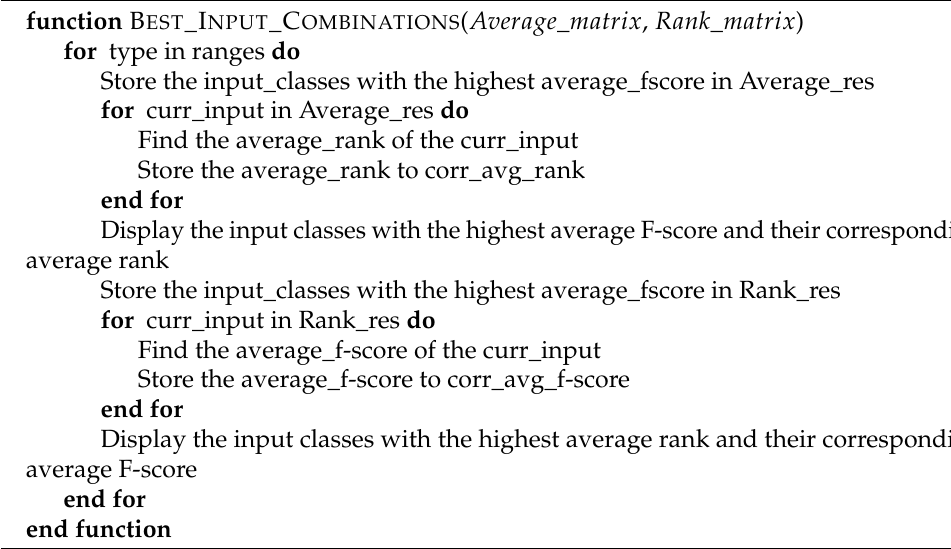
Algorithm 1 Optimal Input Combination